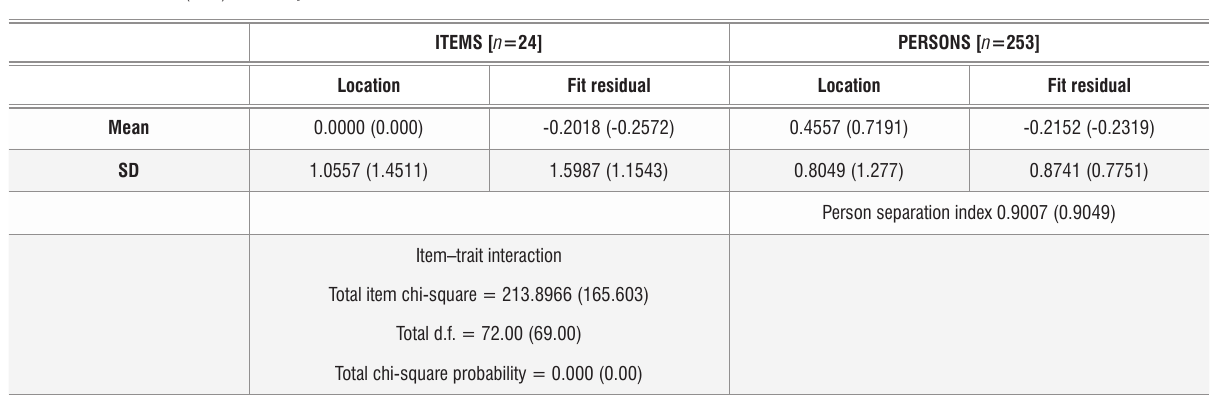
Initial and (final) summary